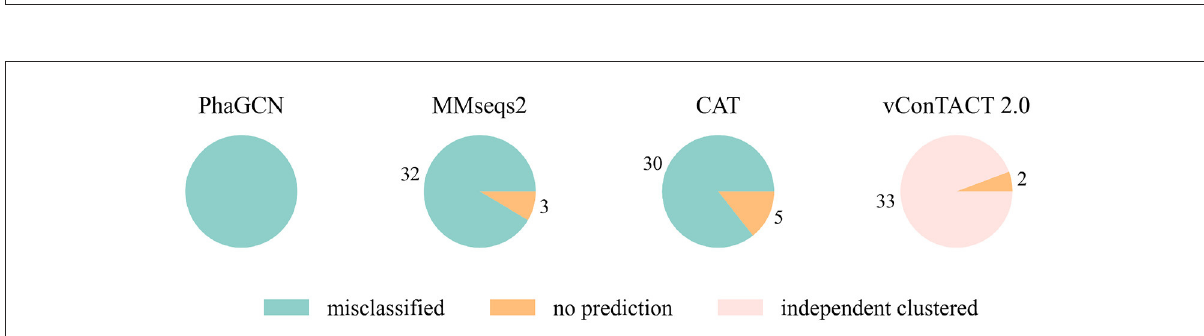
FIGURE2 The classification result of Rountreeviridae sequences in tools that are retrained by removing all Rountreeviridae sequences. “independent clustered”: The sequences are in a VC cluster without any reference genome.